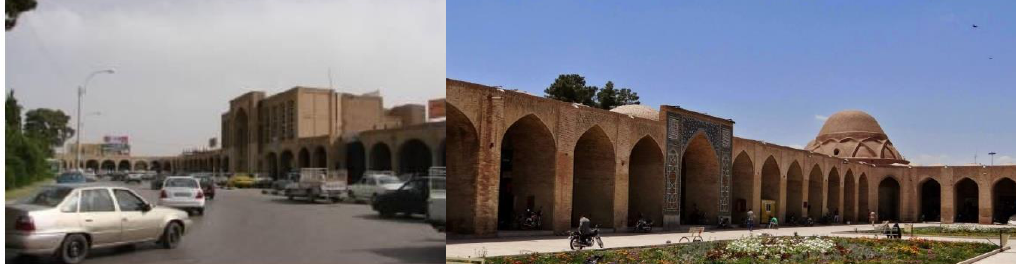
Figure 3. Main open public spaces in the